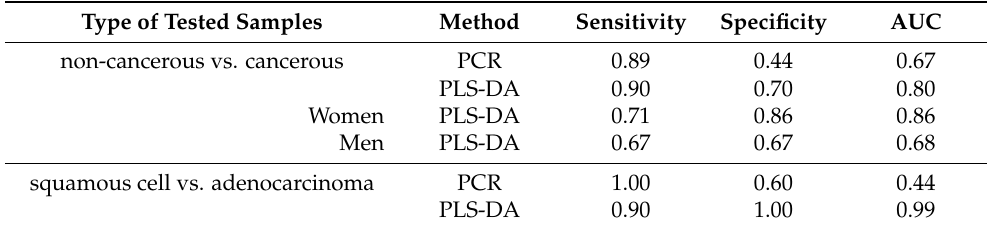
Table 2. Results for PCR and PLS-DA classification model for non-cancerous vs. cancerous samples and squamous cell vs. adenocarcinoma